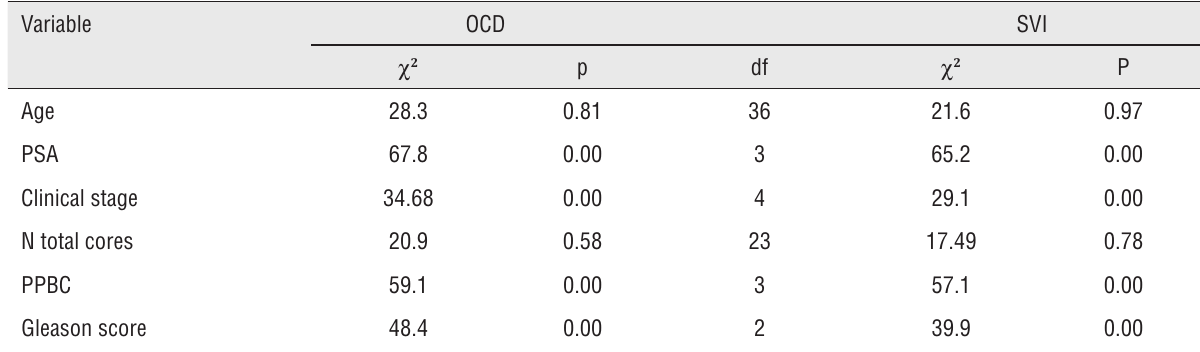
Table 2 - Univariate analysis for OCD and SVI prediction.